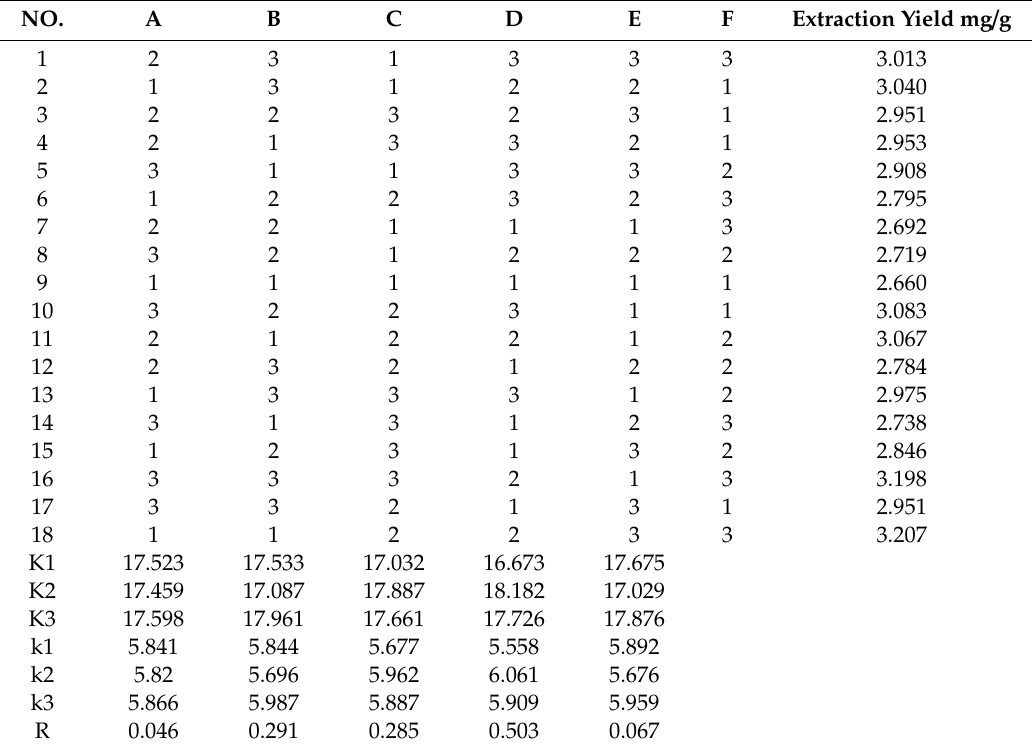
Table 2. Results of extreme